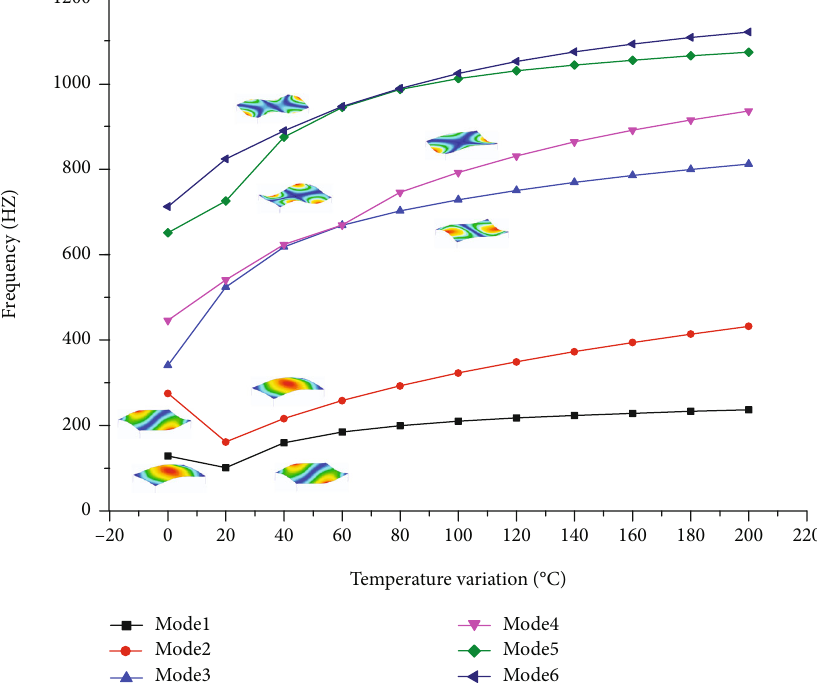
Figure 15: Frequency change curve with temperature variation for point